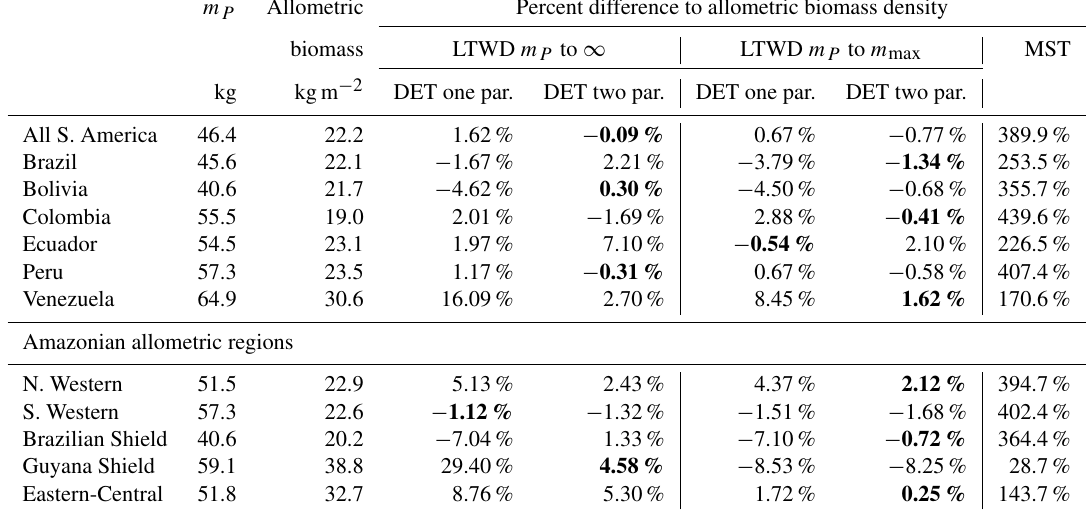
Table 7. Model biomass comparison. Table shows the percentage difference between each model of the biomass density predicted by the parameters obtained from fitting the mass distribution using MLE and the allometric mass in the dataset. This comparison is only for data where the tree mass is greater than the peak in the mass distribution m P . Bold indicates the model that is the closest fit to the allometric value.